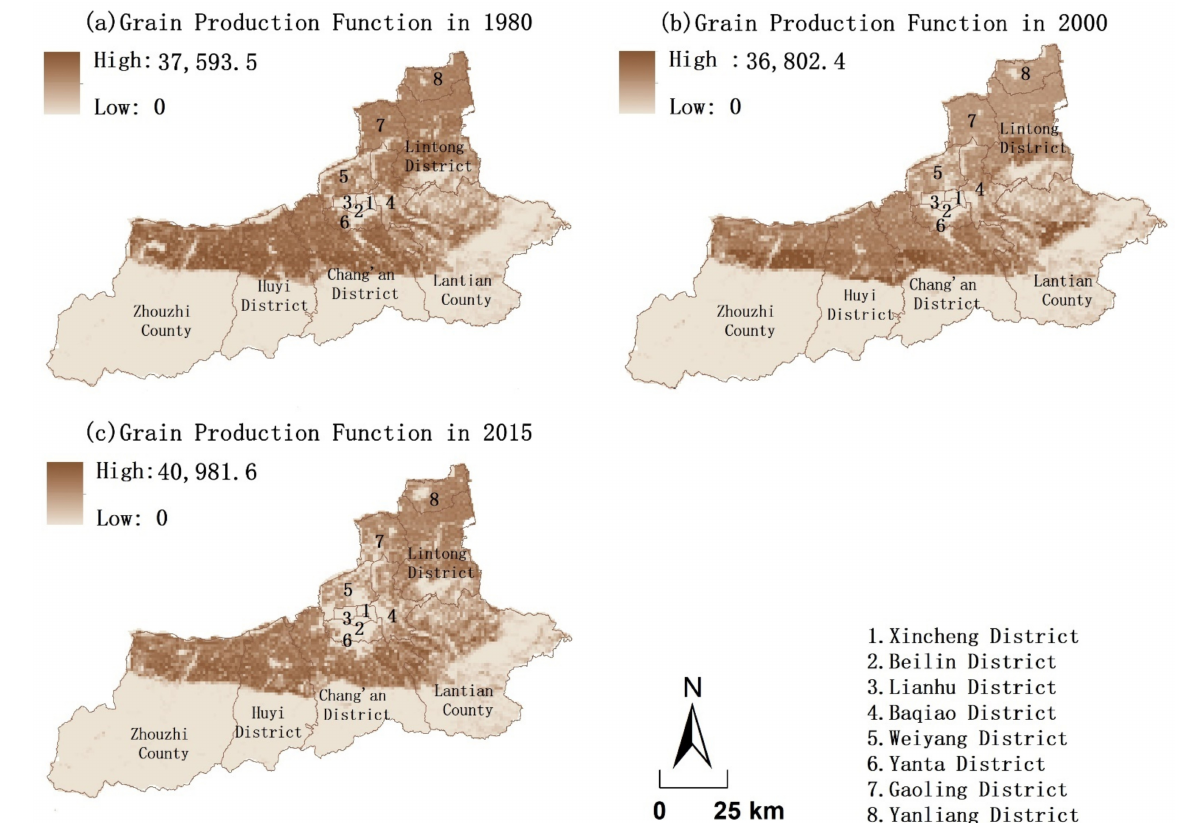
Figure 4. Spatial distribution of function of grain production in the land system of Xi’an from 1980 to 2015 (1 km × 1